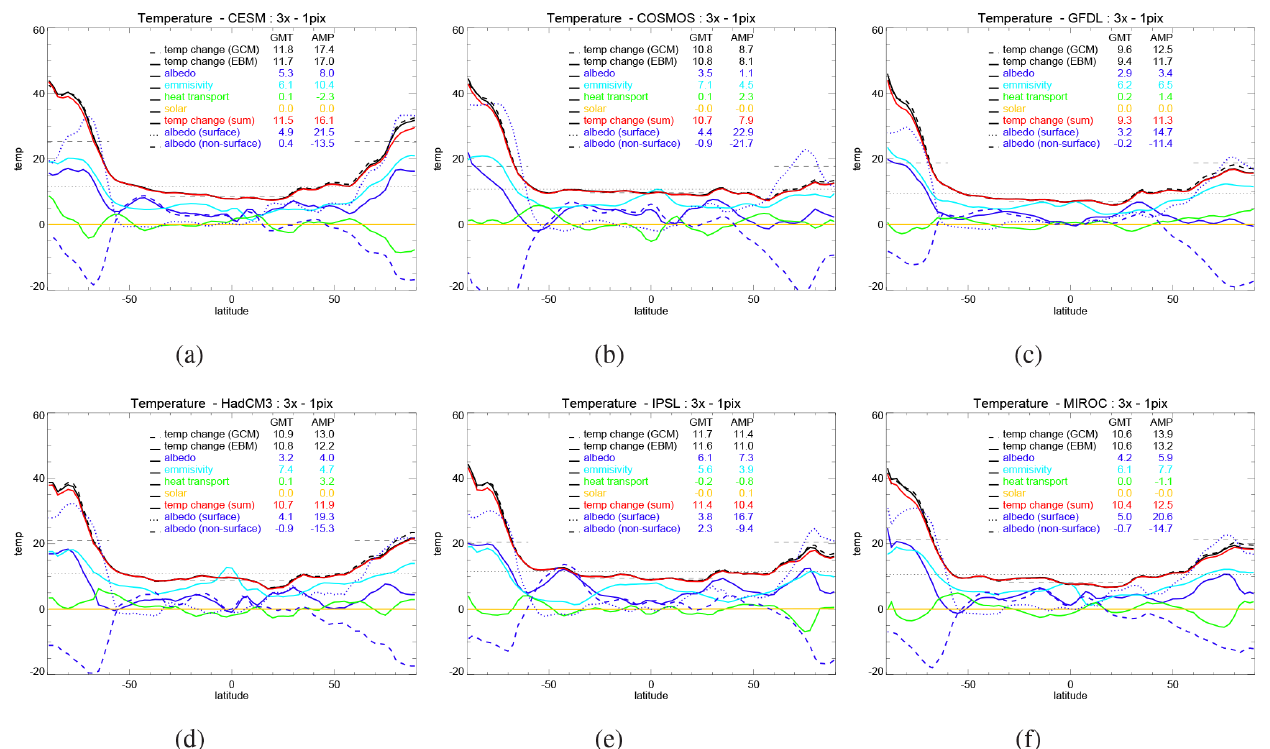
Figure 4. The results of the energy balance analysis as described in Eqs. (2) and (3), applied to the differences between the DeepMIP × 3 simulations and their associated preindustrial controls. The black dashed line shows the zonal mean surface temperature changes directly from the general circulation models (GCMs). The black solid line shows the temperature change derived from the radiative fluxes, (cid:49)τ . Solid blue, cyan, and green lines show the contributions from planetary albedo ( (cid:49)τ (cid:15) ), emissivity ( (cid:49)τ (cid:15) ), and meridional heat flux ( (cid:49)τ (cid:15) ) respectively (Eq. 2). The blue dotted and dashed lines show the contribution from surface albedo ( (cid:49)τ α (Eq. 3). The red line shows the sum of the individual terms. For each model, the contribution of each term to the changes in global mean temperature (GMT) and the polar amplification (AMP; expressed as the difference in warming between the high latitudes, polewards of ± 60 ◦ , and the tropics, ± 30 ◦ ) are quantified in the